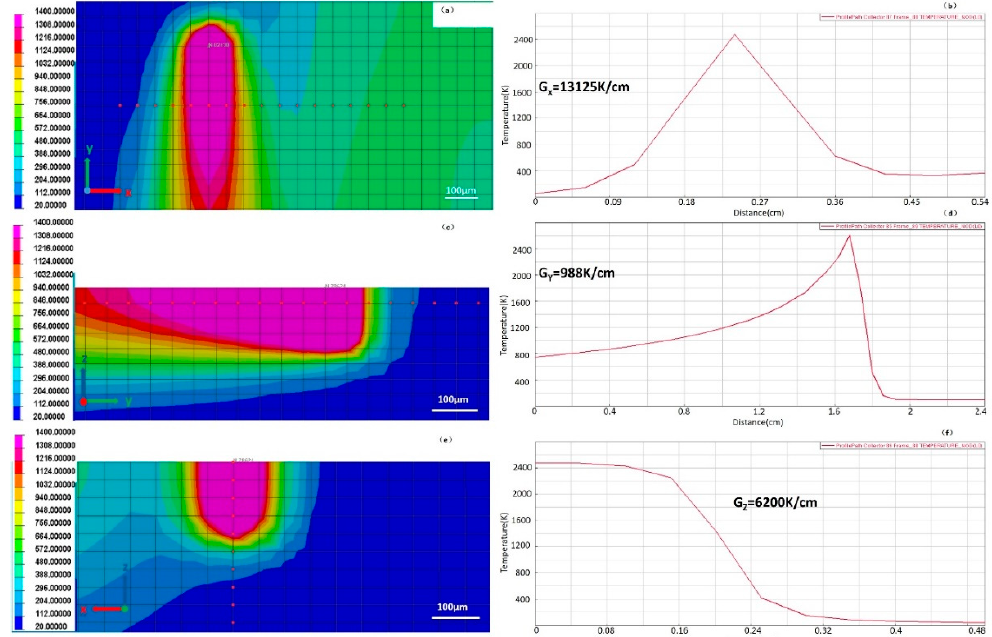
Figure 8. FEM results of 316 L by SLM. The melt pool by a top view ( a ), a longitudinal-section view ( c ) and a cross-section view ( e ), where a plot of node temperature vs. distance can be found in ( b ), ( d ) and ( f ), respectively. The involved nodes are also marked separately in (a), (c) and (e). Temperature gradients of the three different directions (G x , G y , G z ) can be calculated, where G x represents the temperature gradient in the top surface melt pool edge, G y represent the gradient in the melt pool tail and G z represent the gradient in the melt pool bottom.